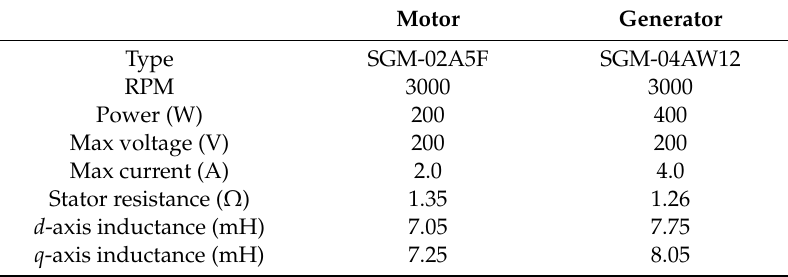
Table 2. Motor and generator parameters.